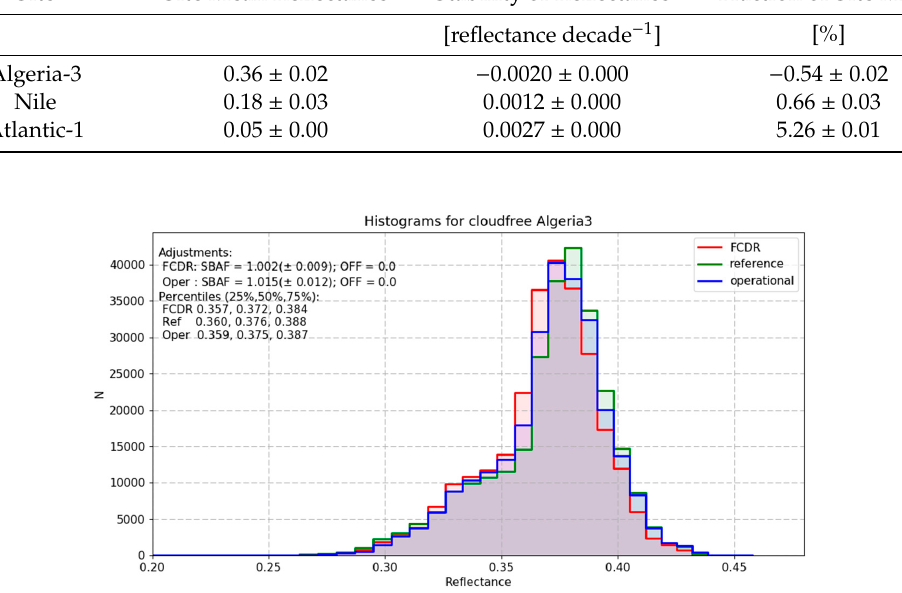
Figure 13. Histogram of SEVIRI HRVIS plotted as reference together with the histograms of the operational MVIRI dataset and the recalibrated MVIRI FCDR, as obtained from cloud-free Algeria-3 pixels at 12:00 UTC slots during March 2005. The MVIRI datasets are band adjusted to the SRF of the SEVIRI HRVIS band according to the given Spectral Band Adjustment Factors (SBAFs). The SBAFs are computed on the same set of SCIAMACHY spectra and the difference between both SBAFs is entirely due to the different shapes of the SRFs in the operational and the FCDR dataset.